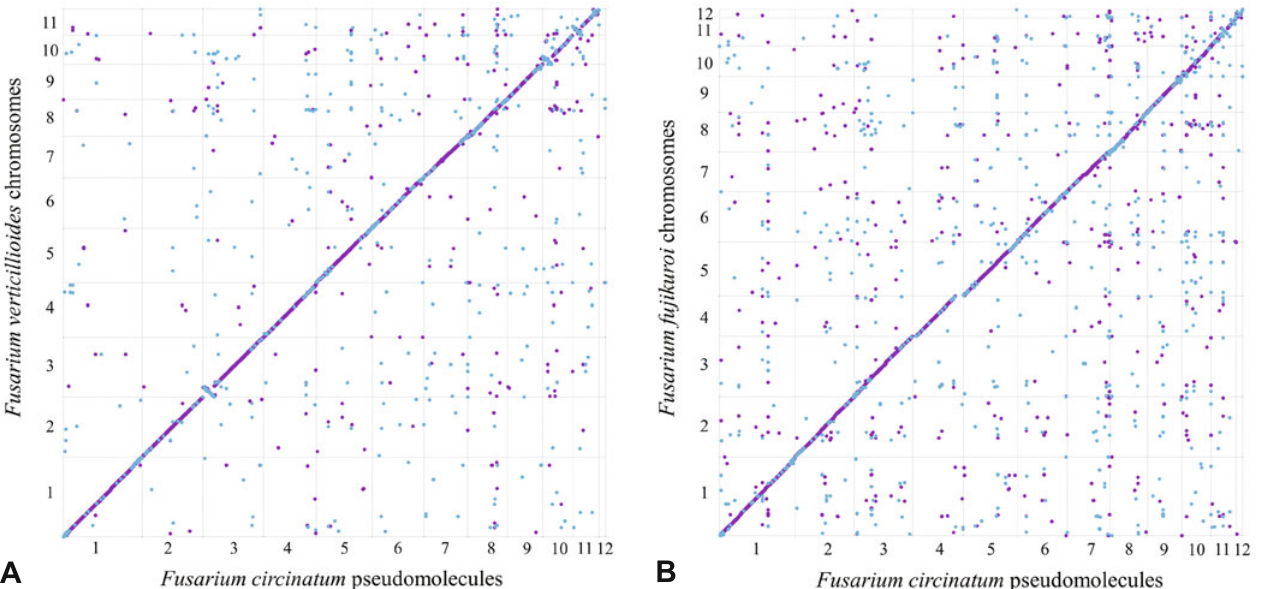
Fig. 3. B(cid:14)(cid:4)(cid:23)(cid:13)(cid:2)(cid:25)(cid:13)(cid:17)(cid:4)(cid:6)(cid:13)(cid:2)(cid:19)(cid:4)(cid:6)(cid:18)(cid:9)(cid:10)(cid:11)(cid:7)(cid:4)(cid:17)(cid:7)(cid:2)(cid:4)(cid:26)x(cid:2) A. Fusarium verticillioides (cid:2)(cid:19)(cid:14)(cid:10)(cid:4)(cid:6)(cid:4)(cid:7)(cid:4)(cid:6)(cid:13)(cid:7)(cid:2)(cid:8)(cid:4)(cid:2) F. circinatum pseudomolecules. B. F. fujikuroi (cid:2)(cid:19)(cid:14)(cid:10)(cid:4)(cid:6)(cid:4)(cid:7)(cid:4)(cid:6)(cid:13)(cid:7)(cid:2) to F. circinatum